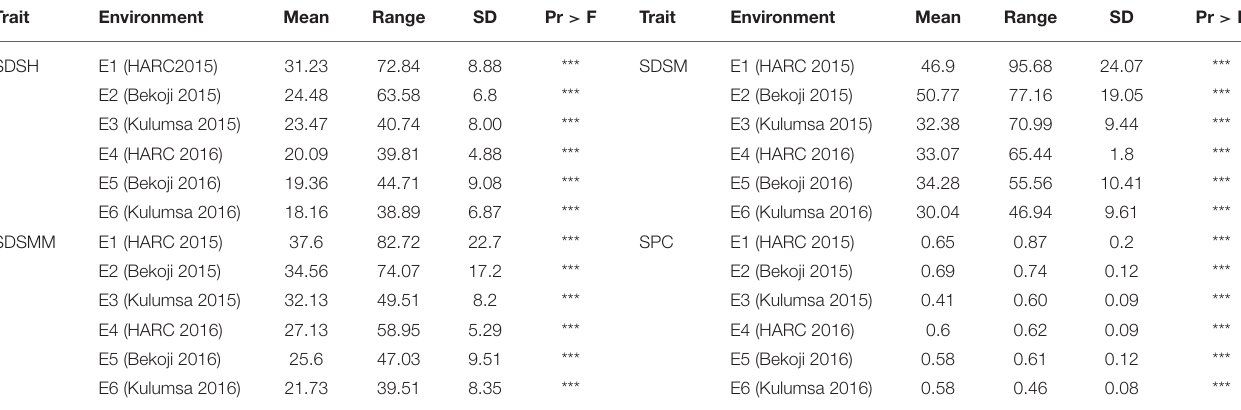
TABLE 1 | Descriptive statistics of SDS values in bread wheat genotypes evaluated in three locations in Ethiopia during the 2015 and 2016 growing seasons. Trait Environment Mean Range SD Pr > F Trait Mean